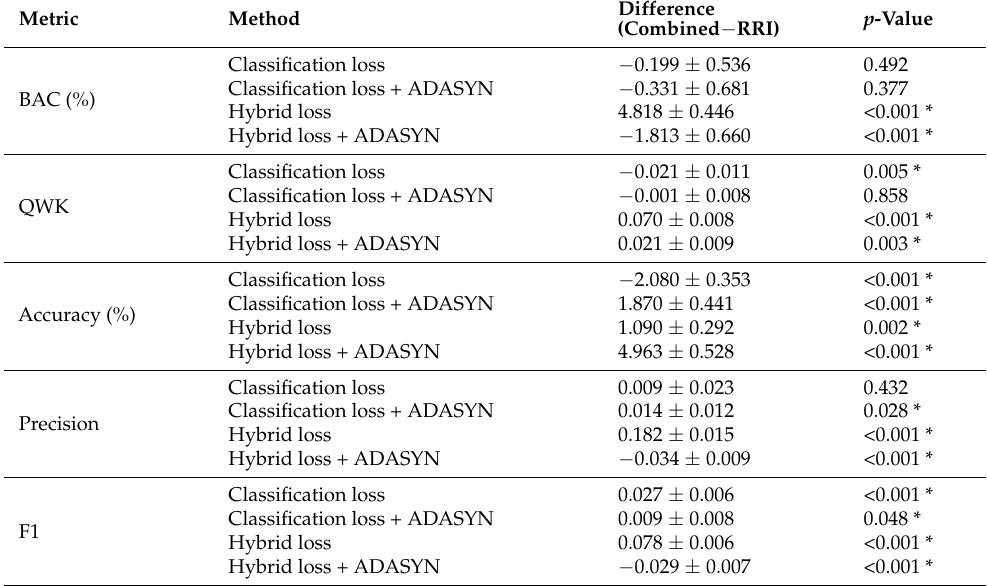
Table 10. Mean and 95% CI of difference in performance metrics between the combined and RRI models. The differences were calculated by subtracting the value of an RRI model from that of a combined model. A two-sample t -test was performed to compare the metrics from the two models (* p <